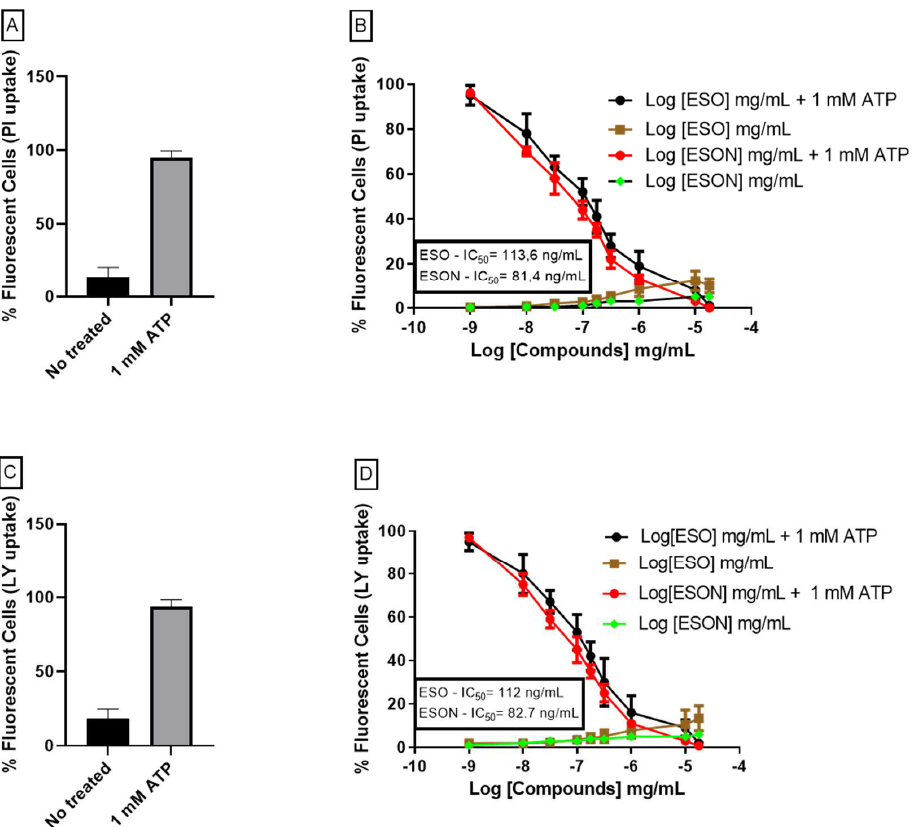
Figure 4. Dose–concentration curves for ESO and ESON inhibition on pore formation activity. ( A ) No treated cells and cells treated with ATP analyzed with PI-uptake assay; ( B ) The graph represents the quantification of dye uptake assays performed to 37 °C on MPM. Dose-response curves of ESO and ESON with or without 1 mM ATP for 25 min analyzed by fluorescence plate reader to detect the PI uptake; ( C ) No treated cells and cells treated with ATP analyzed with LY-uptake assay; ( D ) dose–response curves of ESO and ESON with or without 1 mM ATP for 25 min analyzed by fluorescence plate reader to detect the LY uptake. Values represent mean + SEM. Profiles are representative of 3–6 independent